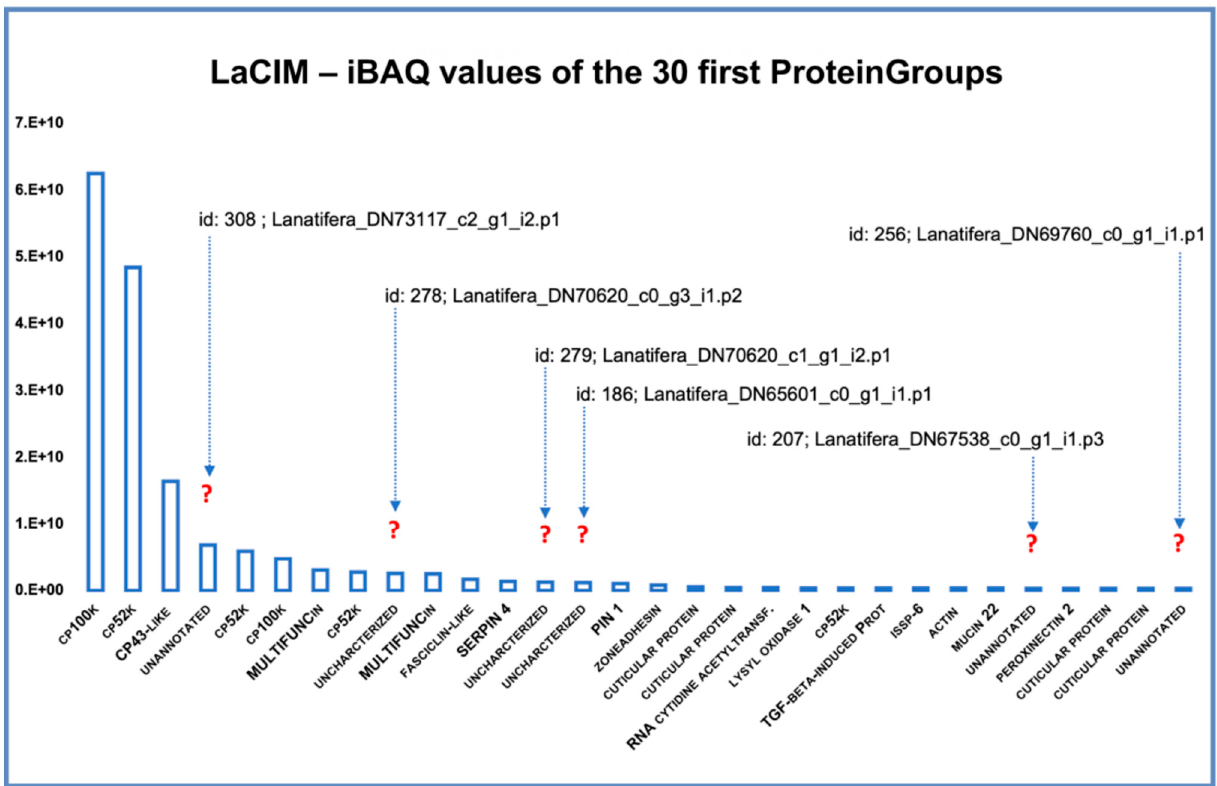
Figure 5. The 30 most expressed proteins in the cement proteome (PPCIM) of the cosmopolitan gooseneck barnacle Lepas antifera , based on the absolute protein abundance. The expression of the 30 most expressed proteins (X-axis) is represented by the intensity Based Absolute Quantification (iBAQ) score (Y-axis) calculated by MaxQuant. Question marks indicate six highly expressed proteins with no homology (named as unannotated in X-axis), found in the cement proteome, their protein Group id, and the name of the corresponding leading protein.